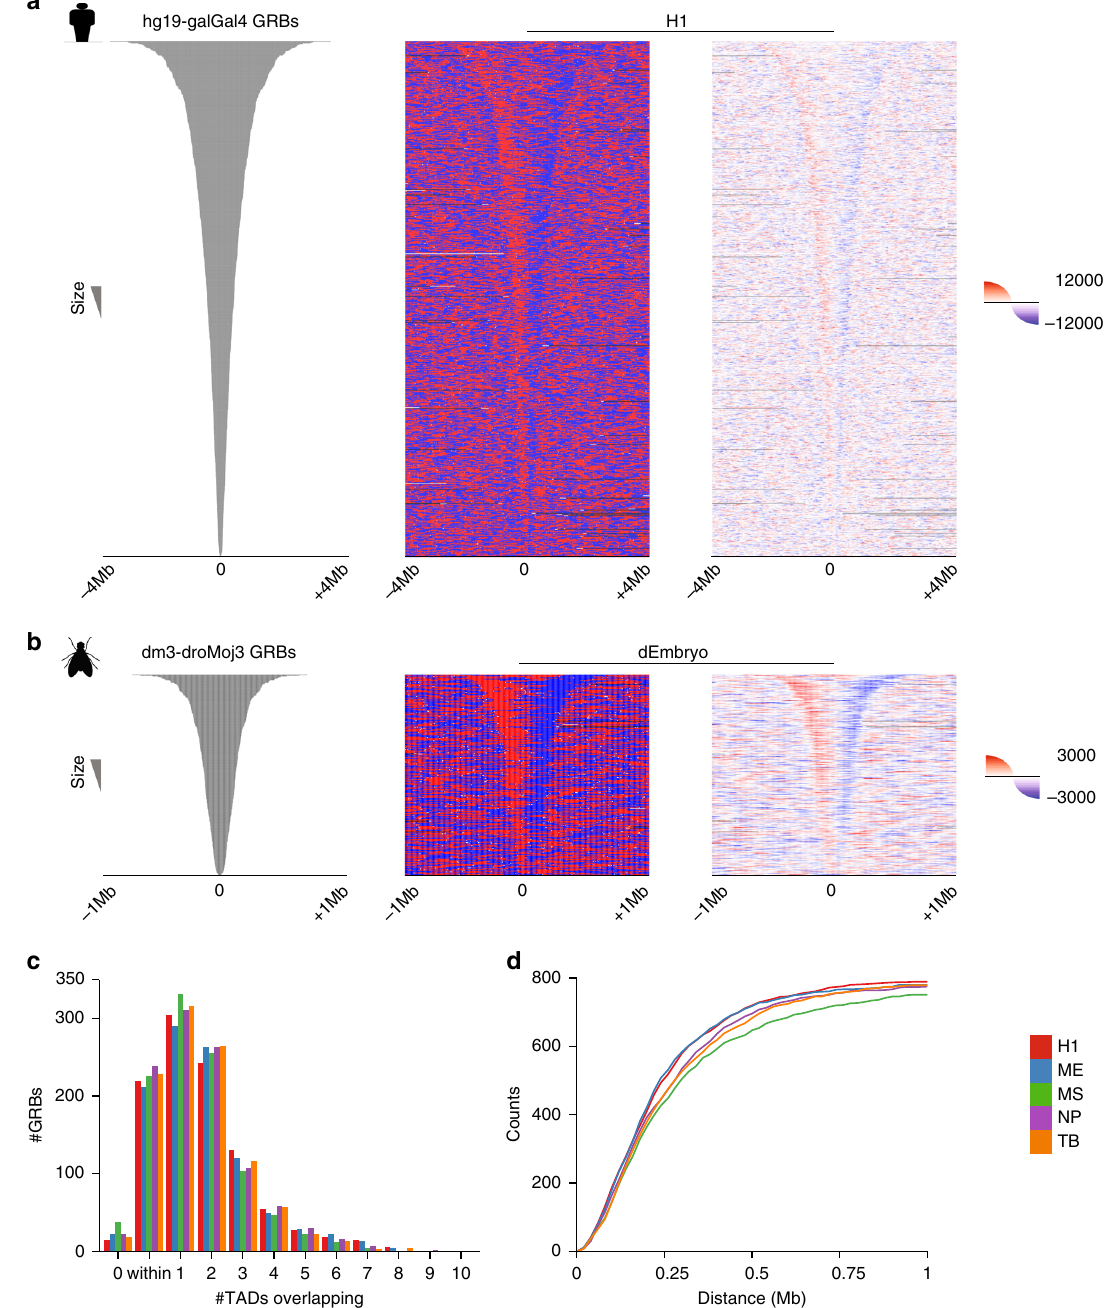
Fig. 2 The boundaries of GRBs predict the boundaries of TADs in multiple evolutionarily distant species. a Heatmaps representing H1-ESC directionality index spanning an 8 Mb window around the centre of putative hg19-galGal4 GRBs. Showing both the overall direction ( middle panel , red for downstream, blue for upstream) and the average raw directionality score in 5 kb bins ( right panel ). b Heatmaps of Drosophila embryo Hi-C directionality index spanning a 2 Mb window around the centre of dm3-droMoj3 GRBs. Showing both the overall direction ( middle panel , red for downstream, blue for upstream) and the average raw directionality score in 1 kb bins ( right panel ). c A large number of GRBs were found to be located within individual TADs (identi fi ed using HOMER) or overlapping only a single TAD, regardless of cell lineage (H1-ESC (H1), mesenchymal stem cells (MS), mesendoderm (ME), neural progenitor cells (NP) and trophoblast-like (TB)). d Cumulative distribution of distance to nearest TAD (HOMER) boundaries from GRB boundaries in different cell lineages considering both edges, i.e., both the start and end positions of a GRB lie within X kb of the nearest TAD start and